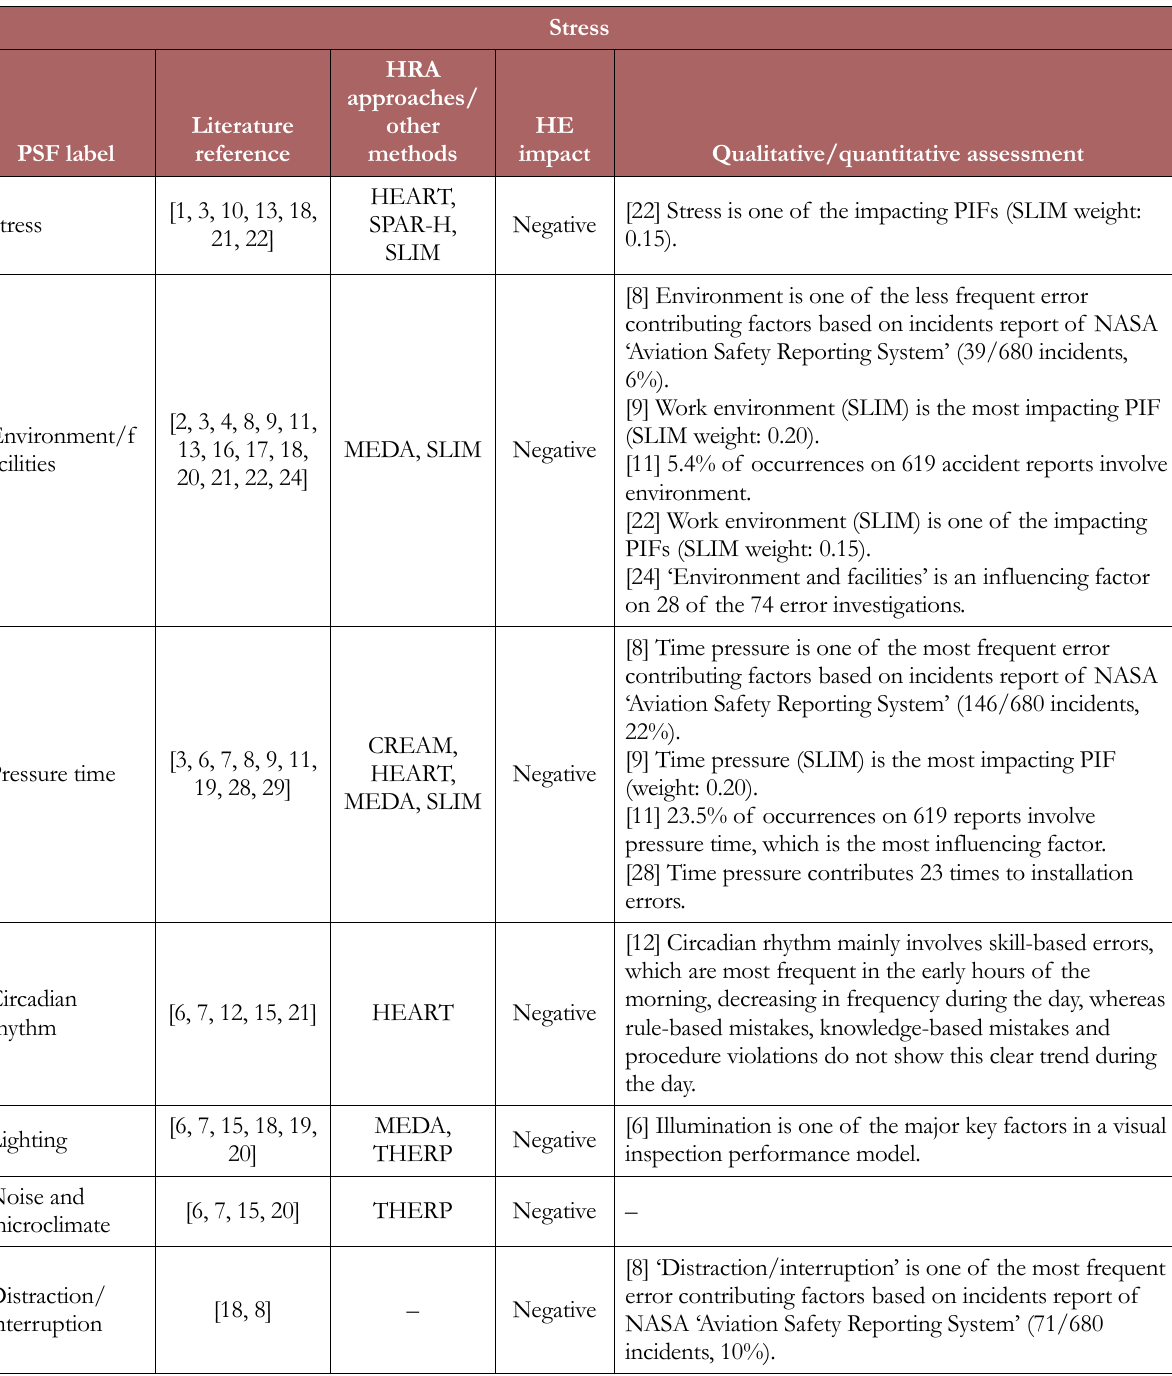
Table 5. Taxonomy of maintenance PSFs: stress